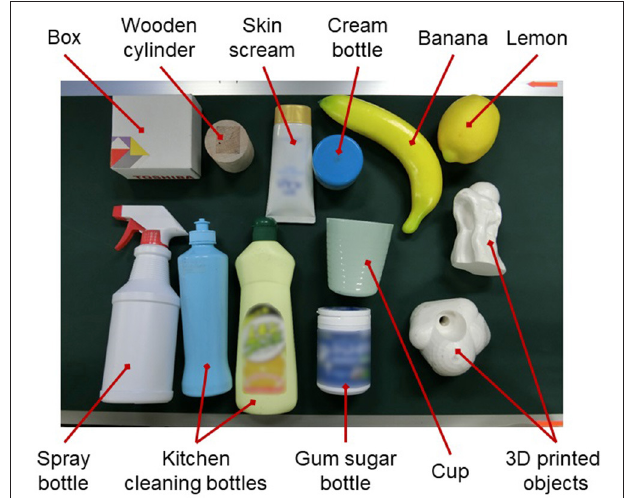
FIGURE 5 | Experiment object